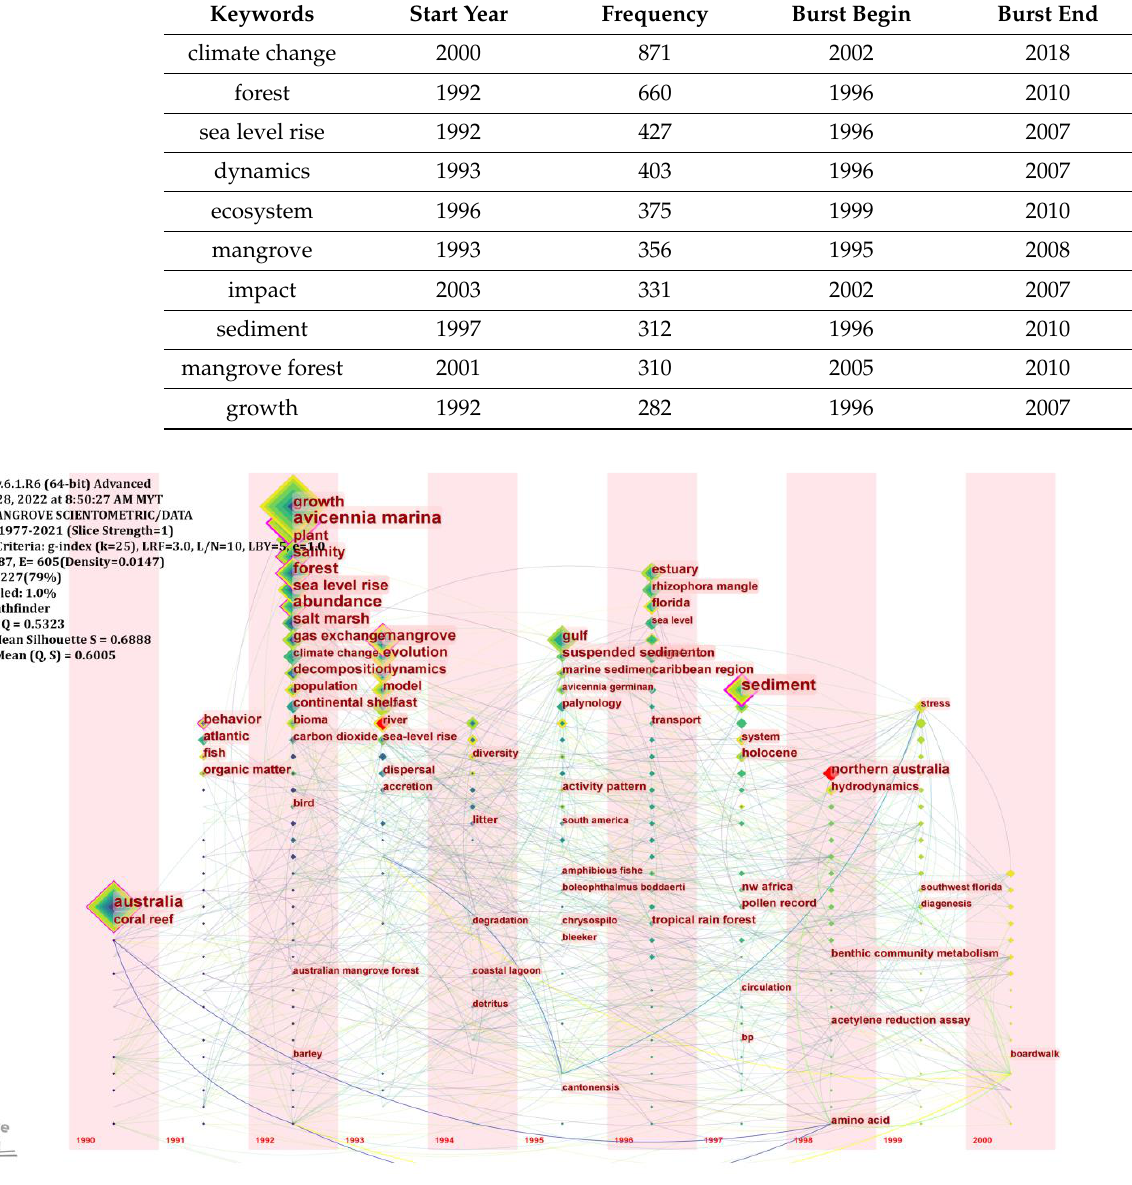
Figure 10. Keyword co-occurrence network from 1990 to 2000 for mangrove and climate change- related publications.